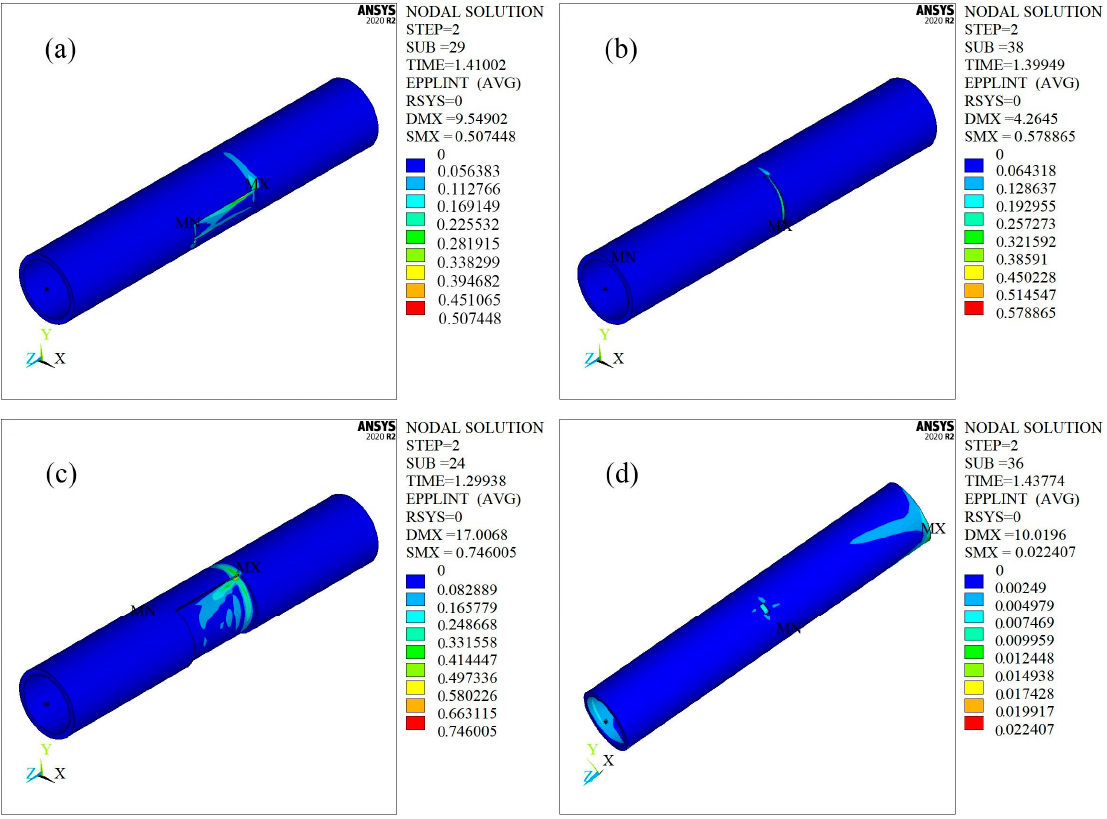
Figure 6. The plastic strain contours of a straight pipe with a local wall-thinning defect under complex loads: ( a ) axial defect; ( b ) circumferential defect; ( c ) large-area defect; ( d ) small-area defect.